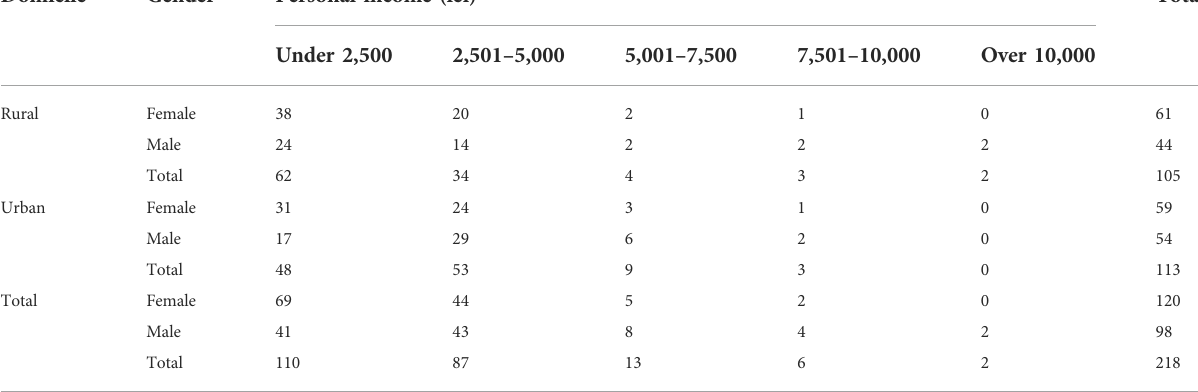
TABLE 2 Cross tabulation between domicile, gender, and average personal income ( N =